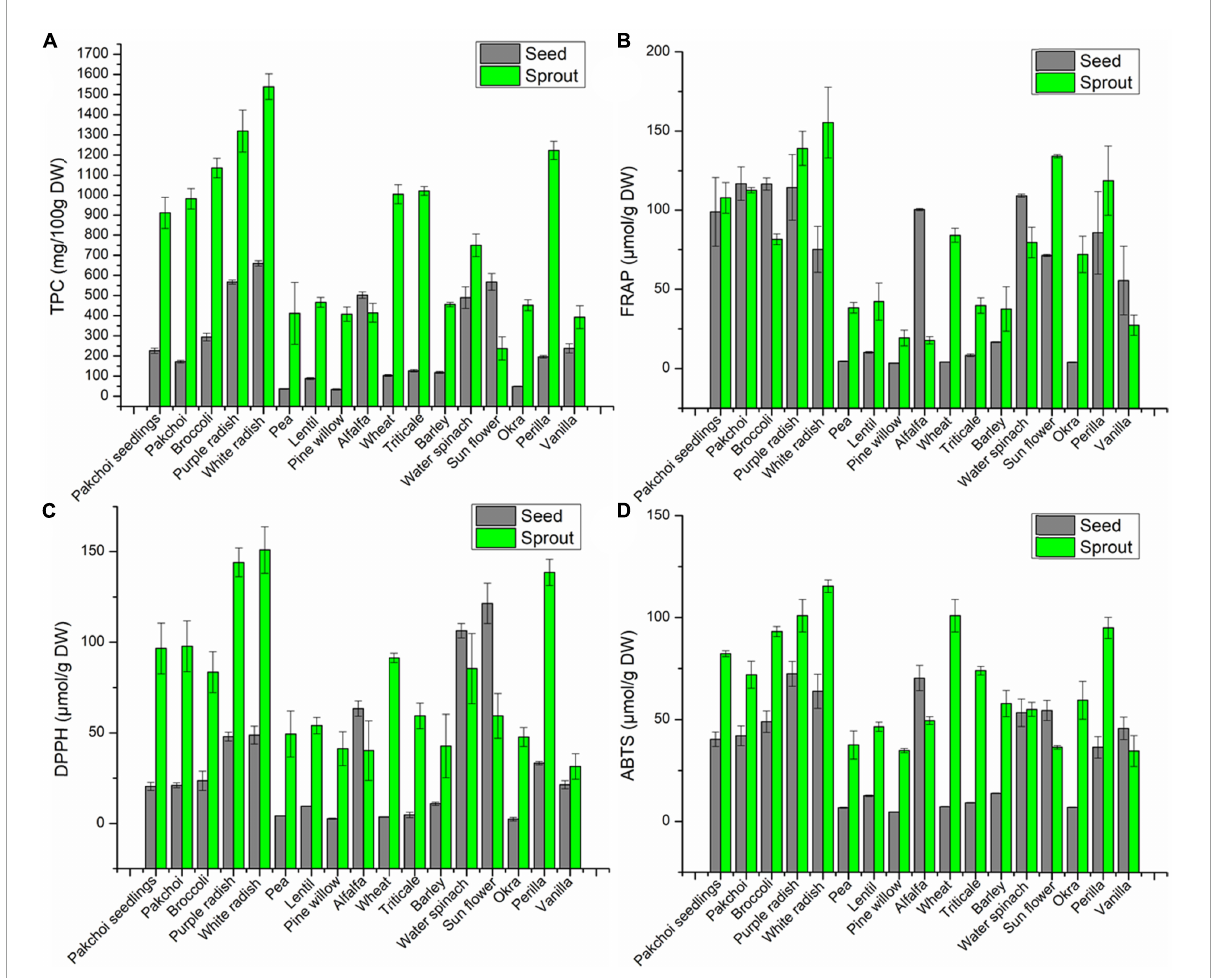
FIGURE1 The TPC (A) , FRAP (B) , DPPH (C), and ABTS (D) values of 17 seeds and their